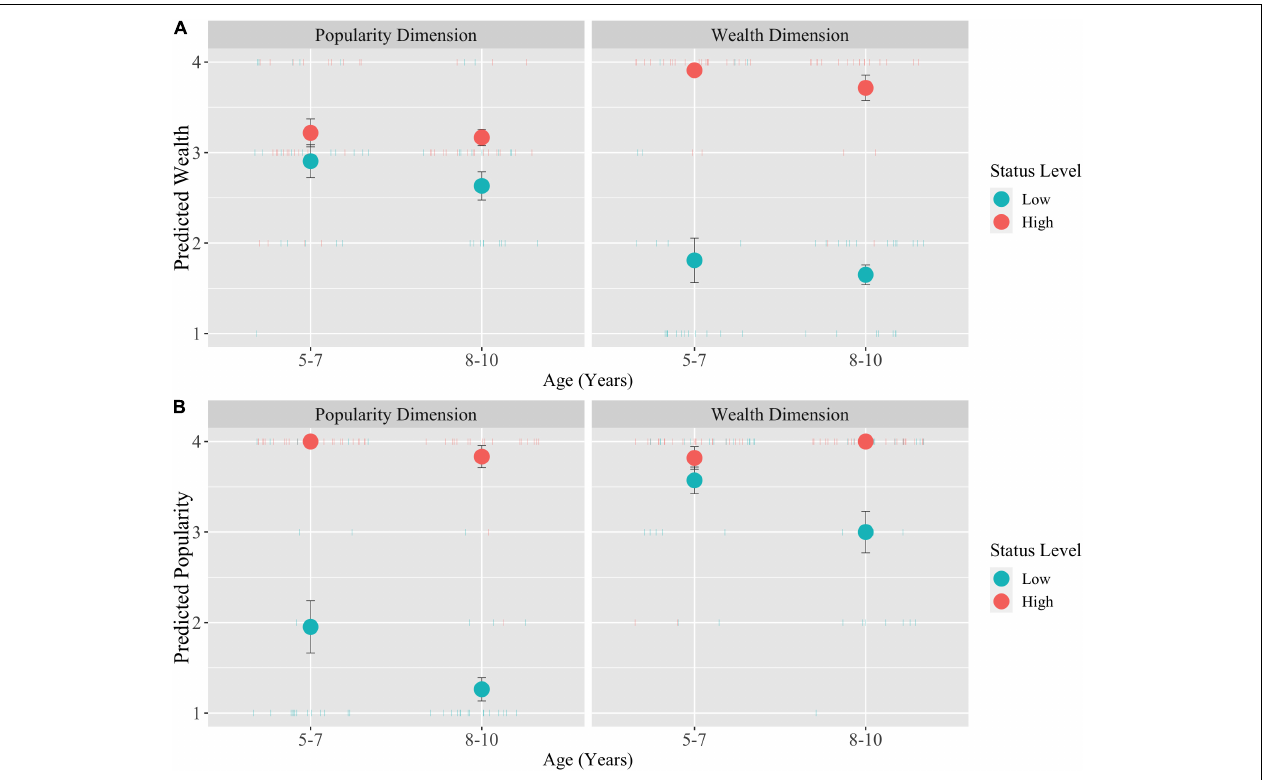
FIGURE 1 | Children’s associations between wealth and popularity (with standard error bars). (A) Predicted wealth as a function of age, status dimension, and status level. (B) Predicted popularity as a function of age, status dimension, and status level.